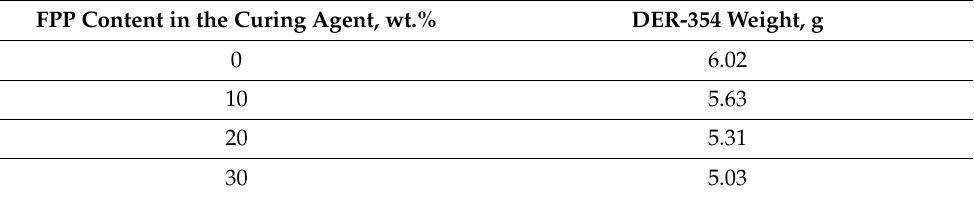
Table 2. The amount of resin dosed with the curing agent vs. The modifier content. FPP Content in the Curing Agent,